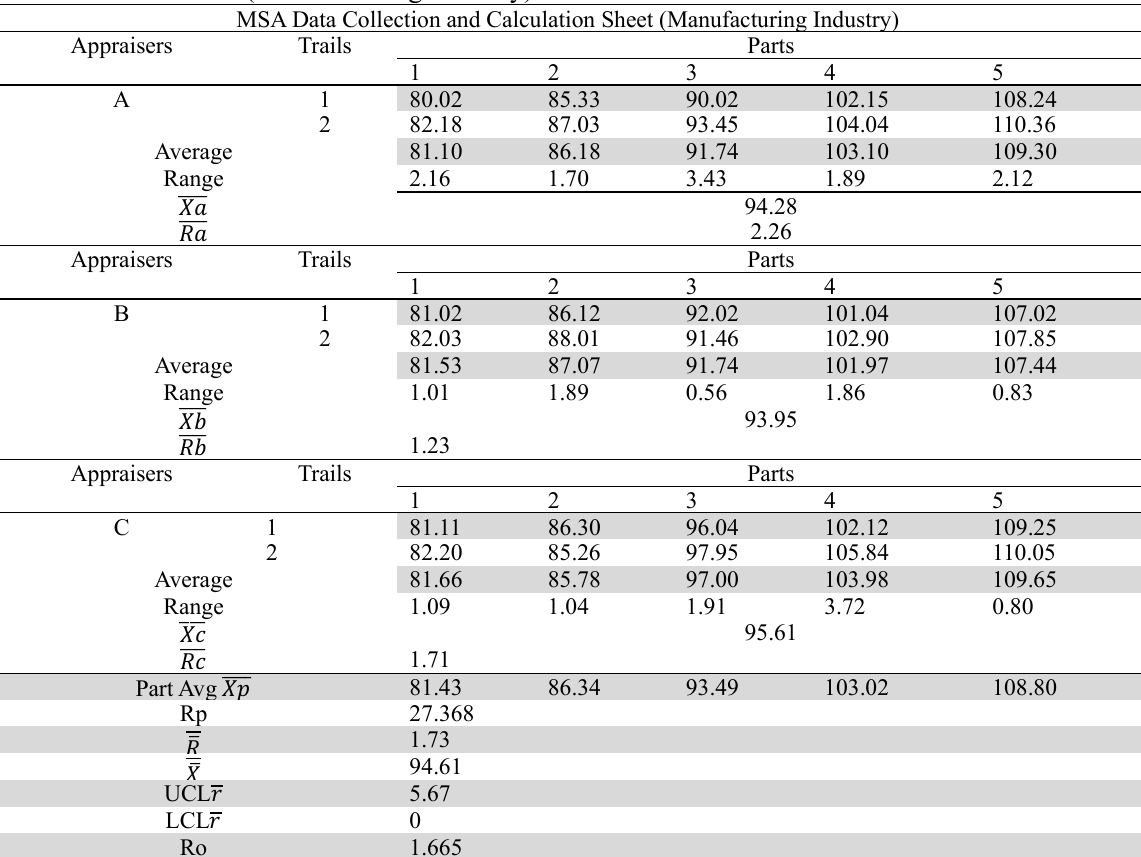
Data Collection Sheet (Manufacturing Industry) MSA Data Collection and Calculation Sheet (Manufacturing